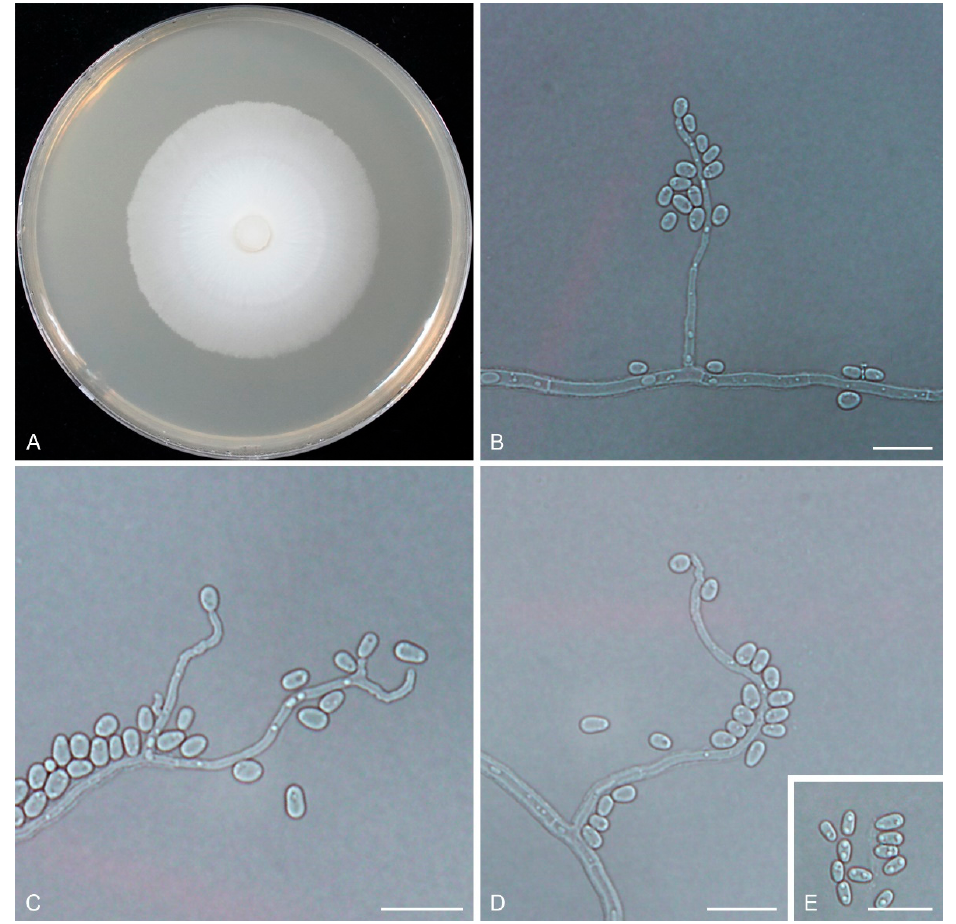
Figure 2. Morphological characteristics of Ceratocystiopsis subelongati : ( A ) 22-day-old culture on MEA, ( B – D ) conidiogenous cells of sporothrix- to hyalorhinocladiella-like asexual morph and conidia, and ( E ) conidia. Scale bars: ( B – D ) = 10 µ m.